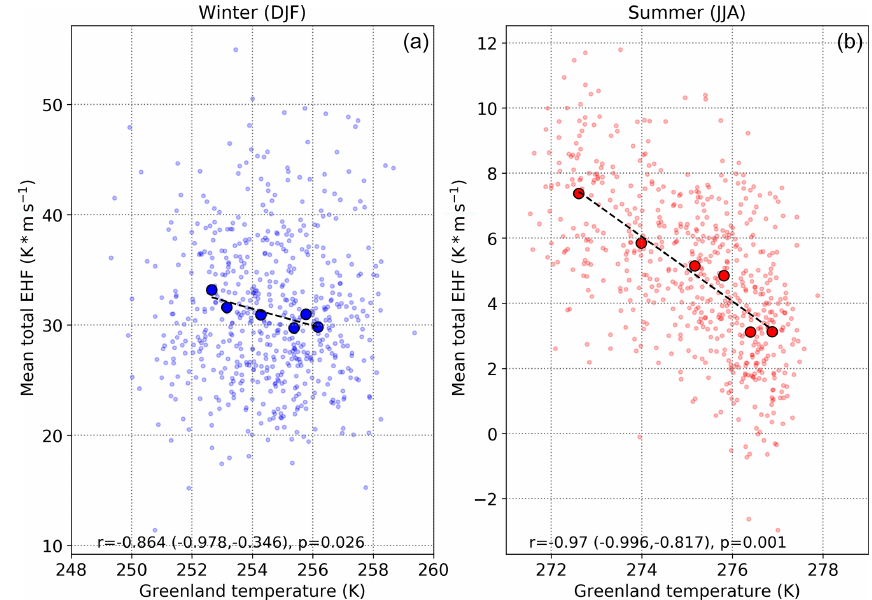
Figure 4. Correlations between the mean surface air temperature around Greenland (55–85 ◦ N, 280–350 ◦ E) and the seasonal-mean total (stationary + transient) eddy heat flux over the North Atlantic (40–80 ◦ N, 290–0 ◦ E). Correlations, p values, and trend lines are calculated using mean values of temperature and EHF anomalies for each of the six time slices. Individual years are lightly colored small dots, and the mean of each of the six time slice simulations are given by large, outlined dots.